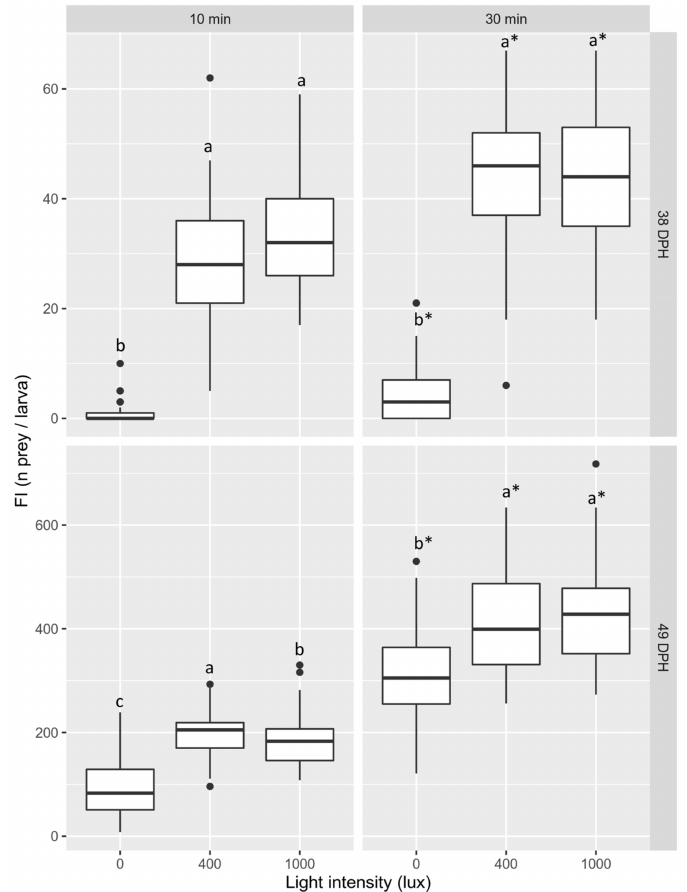
Figure 4. Feeding intensity (FI) of Sparus aurata larvae, aged 38 and 49 days post-hatching (DPH), 10 and 30 min after being fed under different light conditions. Different letters represent significant differences at different times after feeding (Kruskal–Wallis, p < 0.05, followed by paired comparisons using Mann–Whitney U test, p < 0.05), whereas asterisks represent differences between 10 and 30 min for each treatment and each age (Mann–Whitney U, p < 0.05). Boxplot: black horizontal line represents the median, the lower and upper white boxes represent 1st and 3rd quartile, the inferior and superior extremes of whiskers represent minimum and maximum values, respectively, and the black dots represent